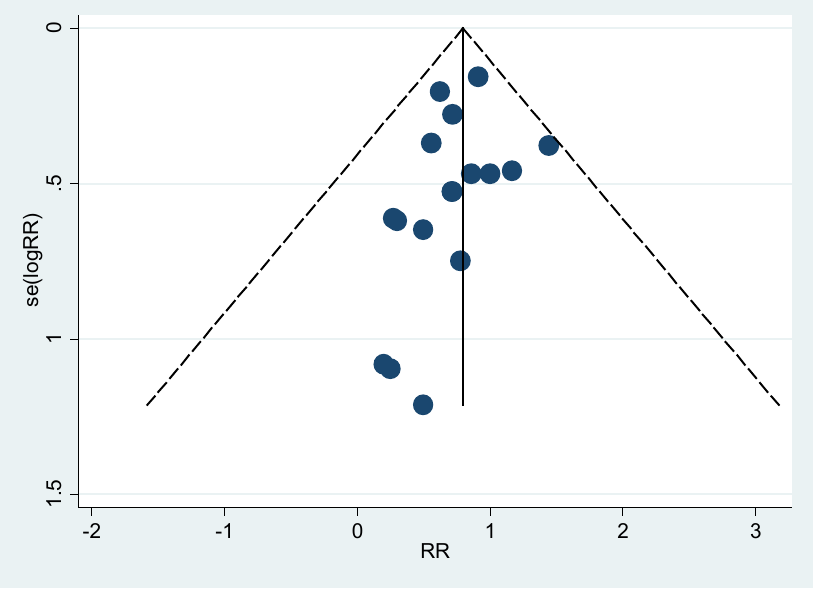
Figure 4: Begg’s Funnel Plot depicting evaluation of potential publication bias for the studies included in the meta-analysis. Each blue dot represents an individual study included in the